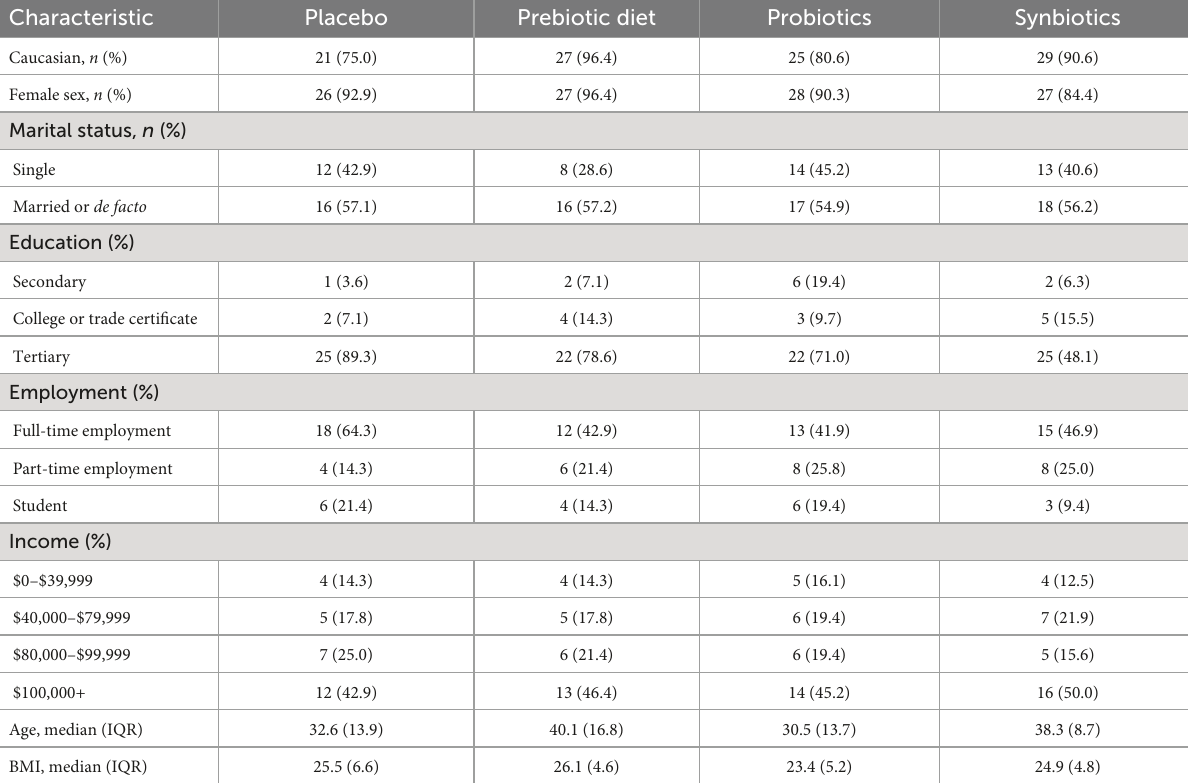
TABLE 1 Sample socio-demographic and clinical features. Characteristic Placebo Prebiotic